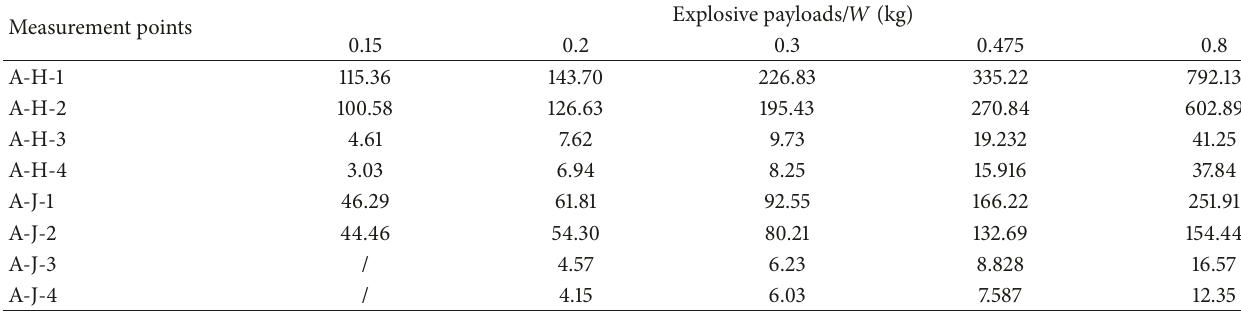
Figure 12: The time curve of the explosive shockwave of Model 1 at P-D-1. Table 7: The strain peak of Model 1 at different measurement points ( × 10 −6 ).